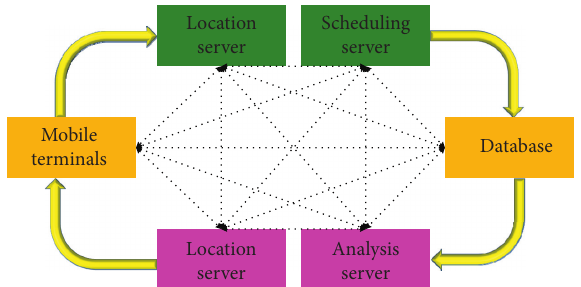
Figure 3: Encounter structure of the system.